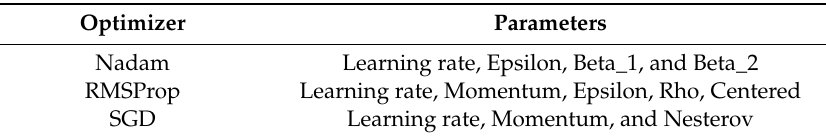
Table 9. Parameters of each optimizer method.